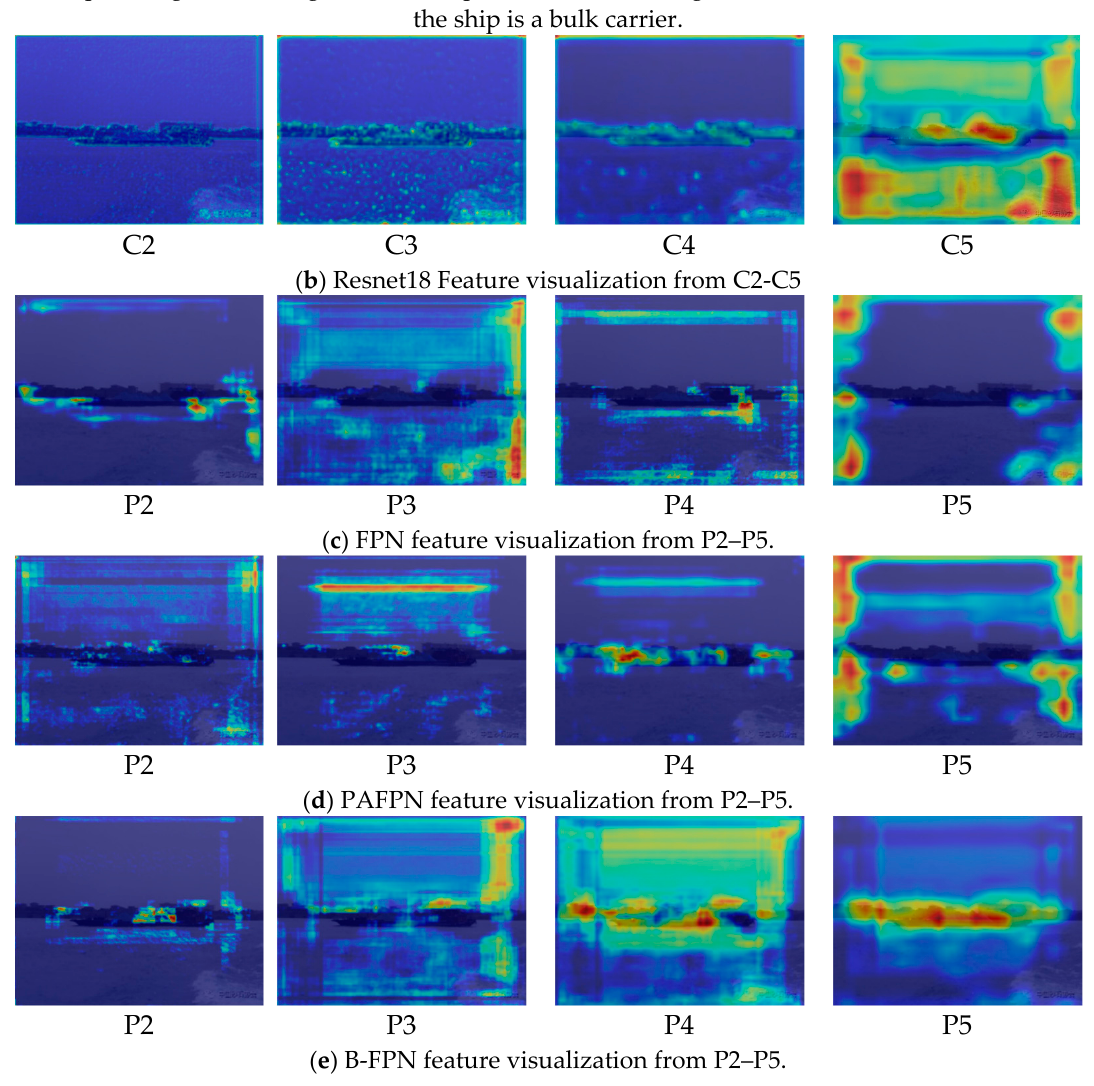
Figure 9. Visualization results of feature layer.